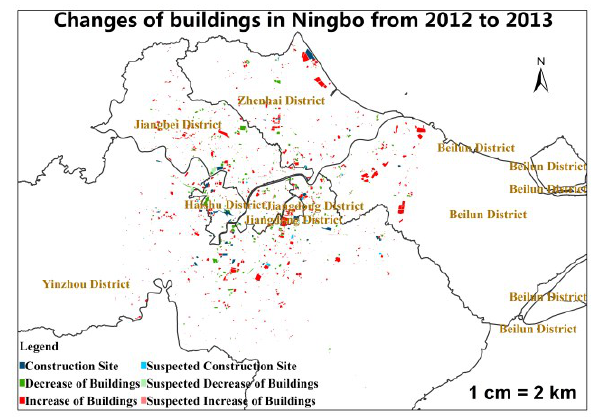
Figure 4. Changes of buildings in Ningbo from 2012 to